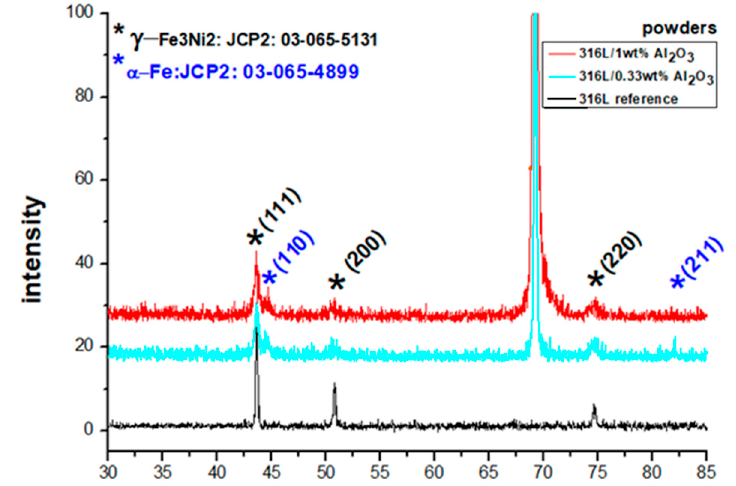
Figure 6. XRD diffractograms of the 316L reference powder, the milled 316L/0.33 wt% Al 2 O 3 and the milled 316L/1 wt% Al 2 O 3 .